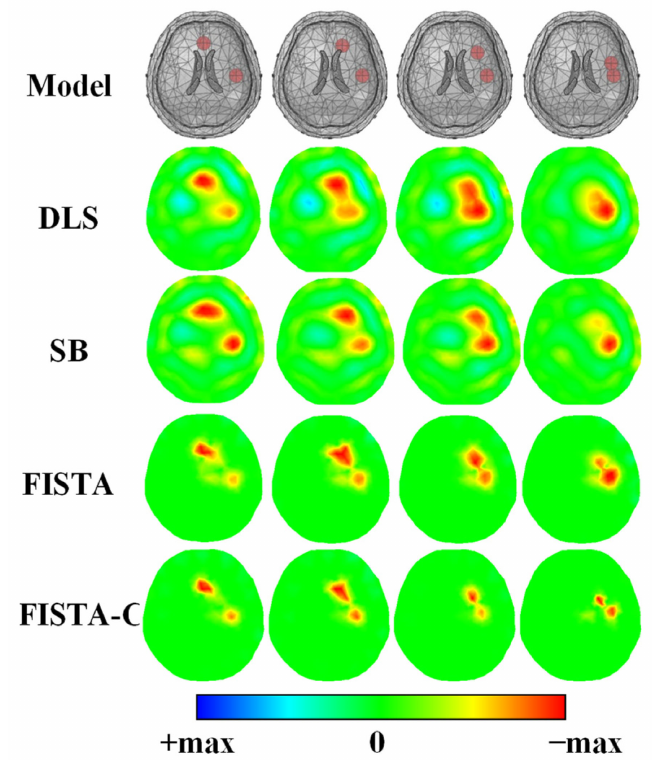
Figure 6. Reconstruction results of a double-lesion target with distances of 7.07, 5.56, 3.83, and 1.95